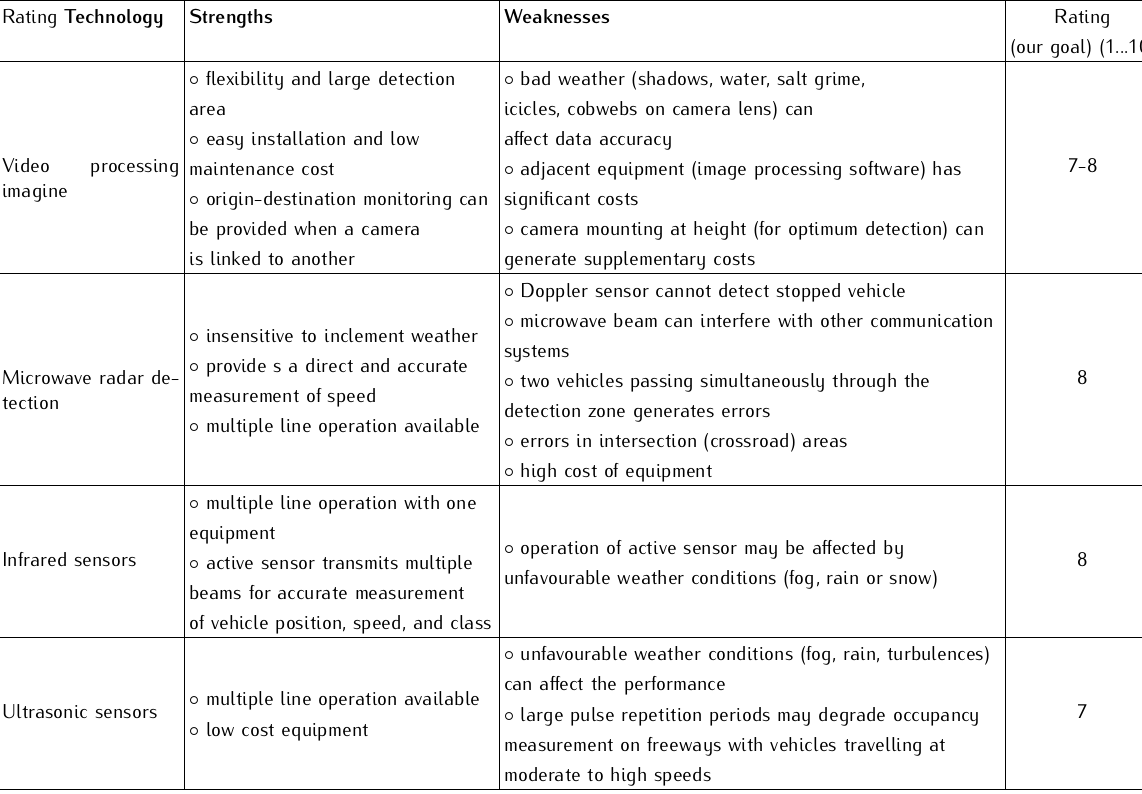
Table 2. Strengths and weaknesses of non-intrusive detection technology [2] Rating